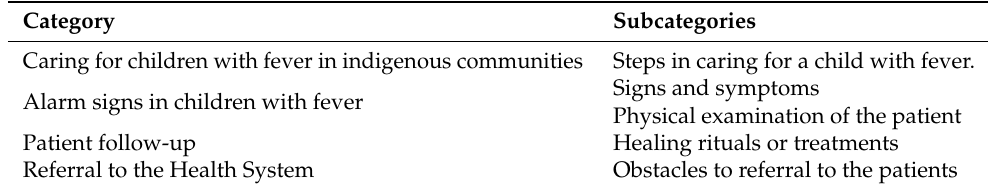
Table 4. Categoy and